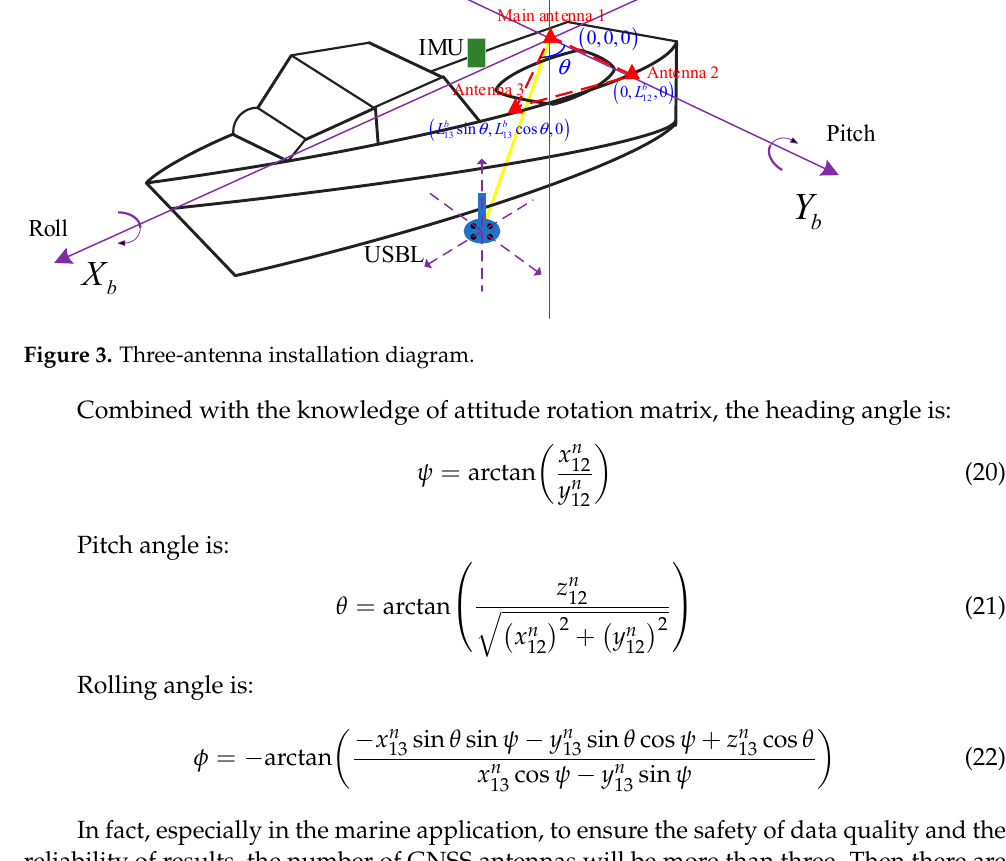
Figure 4. Multi-antenna GNSS/INS loose combination algorithm model.